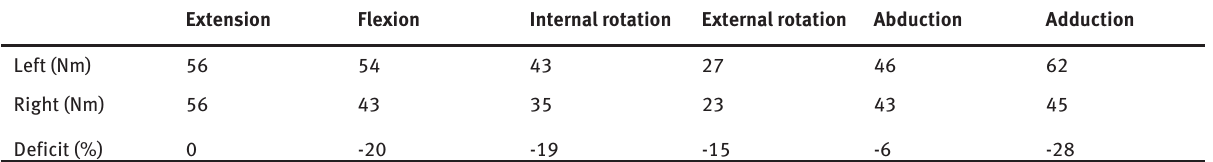
Table 3. Result of isokinetic strength tests at 8 months in Patient